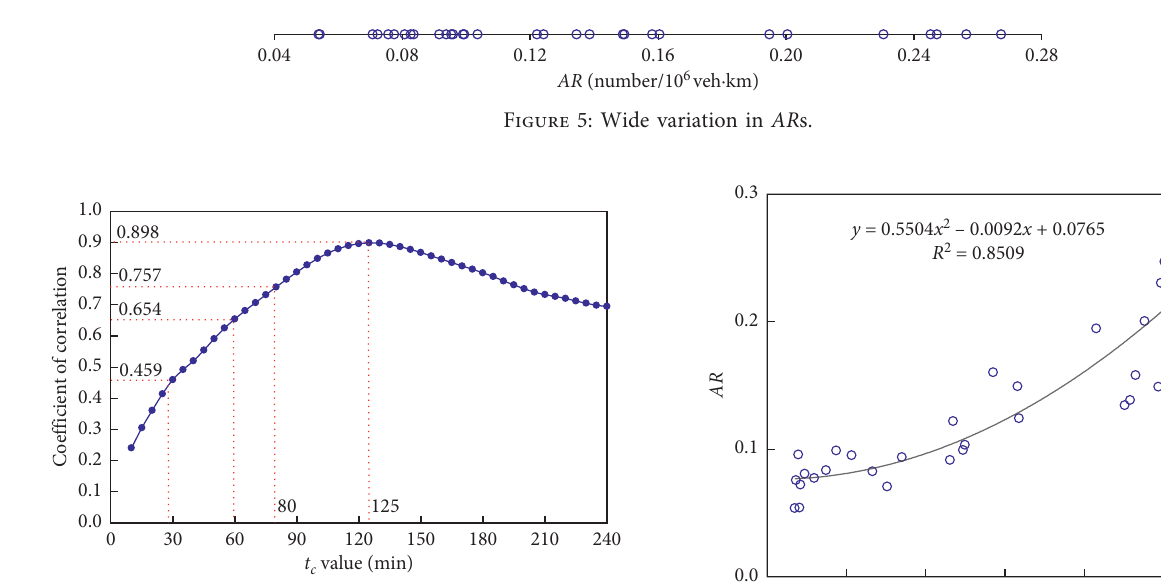
Figure 6: Effects of t c on the relationship between RF and AR .